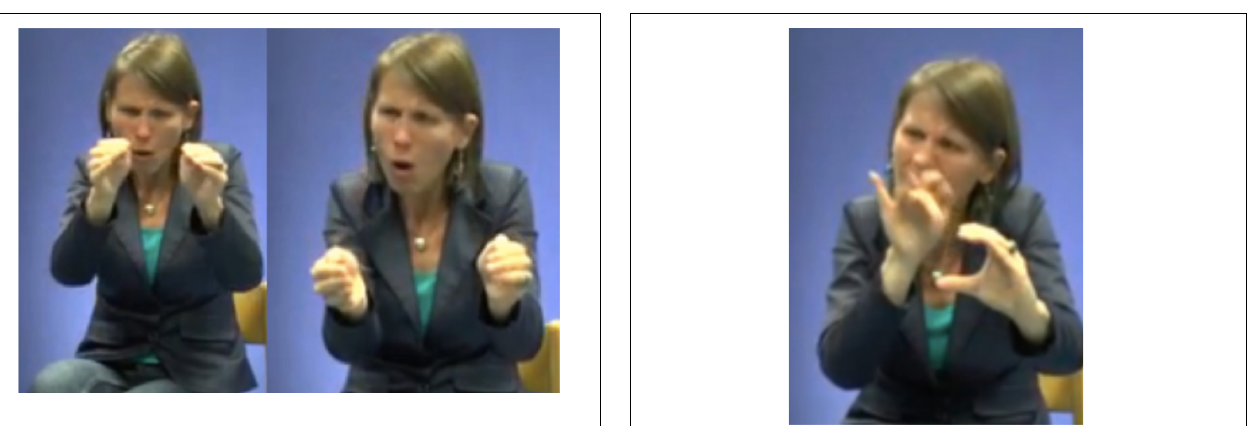
FIGURE 9 | DS: molehill – classifier construction that depicts the shape of the molehill. Figure reproduced with permission from Corpus VGT (Van Herreweghe et al., 2015).